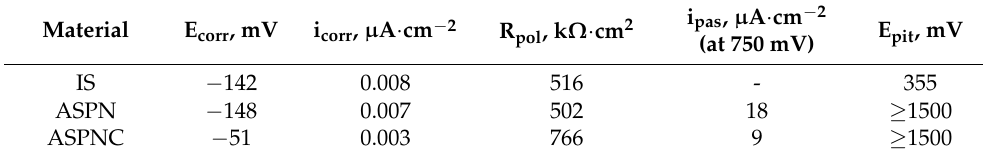
Figure 5. Anodic polarisation curves (up to 1500 mV) of AISI 316L steel in its initial state (IS) and after ASPN and ASPNC. Table 3. Electrochemical values of AISI 316L steel in its initial state (IS) and after ASPN and ASPNC.